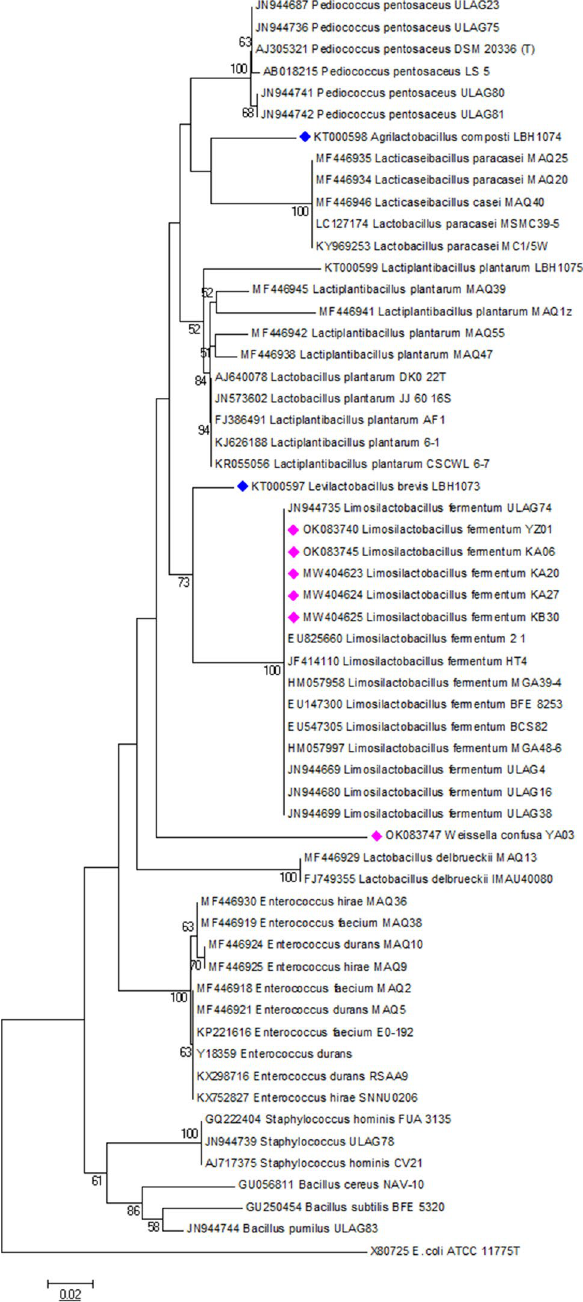
Figure 2. Phylogenetic tree of lactic acid bacteria producing α-Gal based on the alignment of the partial 16S rRNA sequences of the LAB isolates from this study. The evolutionary history was inferred using the Neighbor- Joining method. The optimal tree with the sum of branch length = 0.95913905 is shown. The percentage of replicate trees in which the associated taxa clustered together in the bootstrap test (1000 replicates) is shown next to the branches. The tree is drawn to scale, with branch lengths in the same units as those of the evolutionary distances used to infer the phylogenetic tree. The evolutionary distances were computed using the p-distance method and are in the units of the number of base differences per site. All positions containing gaps and missing data were eliminated. E. coli ATCC_117775T was used as an out group while LAB producing α-Gal was annotated with pink and blue colored bullets. Evolutionary analyses were conducted using